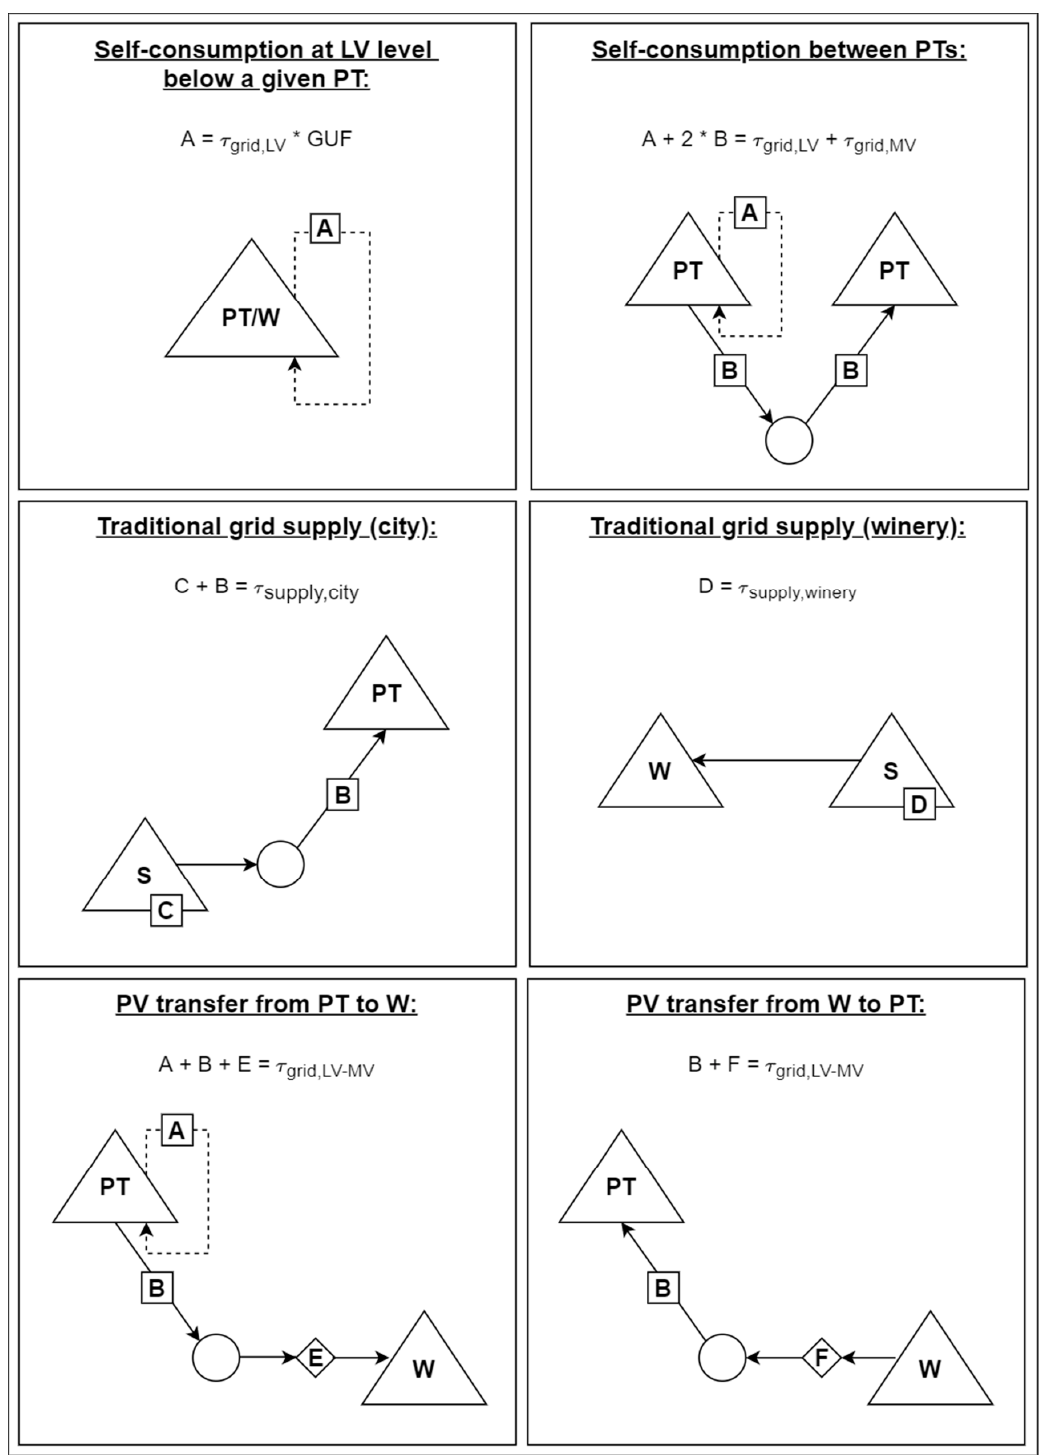
Figure 10. Allocation for the different cost components (A to F) in the designed power grid. The picture depicts how the Calliope parameters incorporate the tariff from the electricity supplied by retailers through the substation (S) to the power transformers that are connected to LV grid sections and the winery (W), τ supply,city and τ supply,winery ; the LV and MV grid use tariffs for energy exchanges between LV prosumers ( τ grid,LV and τ grid,MV ), and the overall use tariff for exchanges between LV and MV prosumers (in this case, the winery (W)). The Grid Use Factor (GUF) is a scalar, parameterizing the percentage of PV generation that uses the public LV grid that flows from the PV system to the respective prosumer(s).